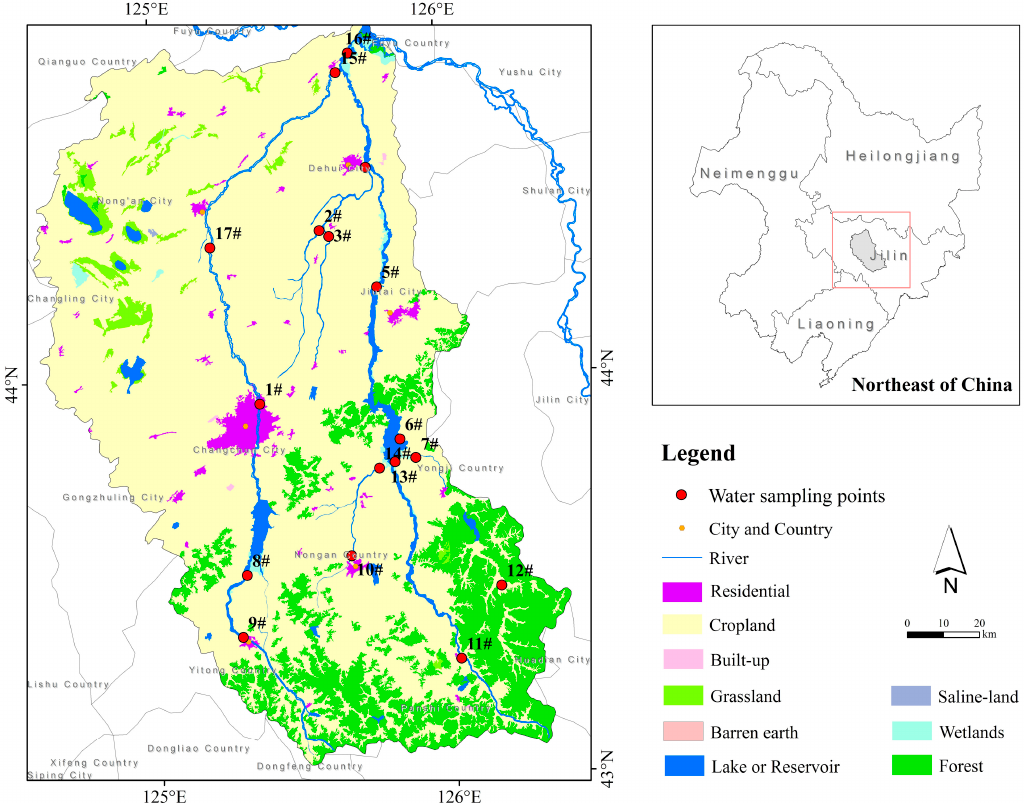
Figure 1. Location and sampling locations of study area, including Yitong River (YT, five sampling locations), Yinma River (YM, 11 sampling locations) and 16# in the confluence of the Yinma and Yitong Rivers. The spatial distribution of sampling locations and CDOM-related parameters were determined with ArcGIS 10.1.